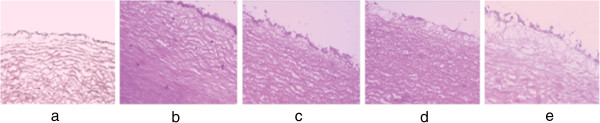
Cross-section of the first portion of aorta stained with hematoxylin and eosin (H&E) under light microscope (magnification×100). a. Control; b. Model; c. Fenofibrate; d. Keampferol-H; e. Keampferol-L.